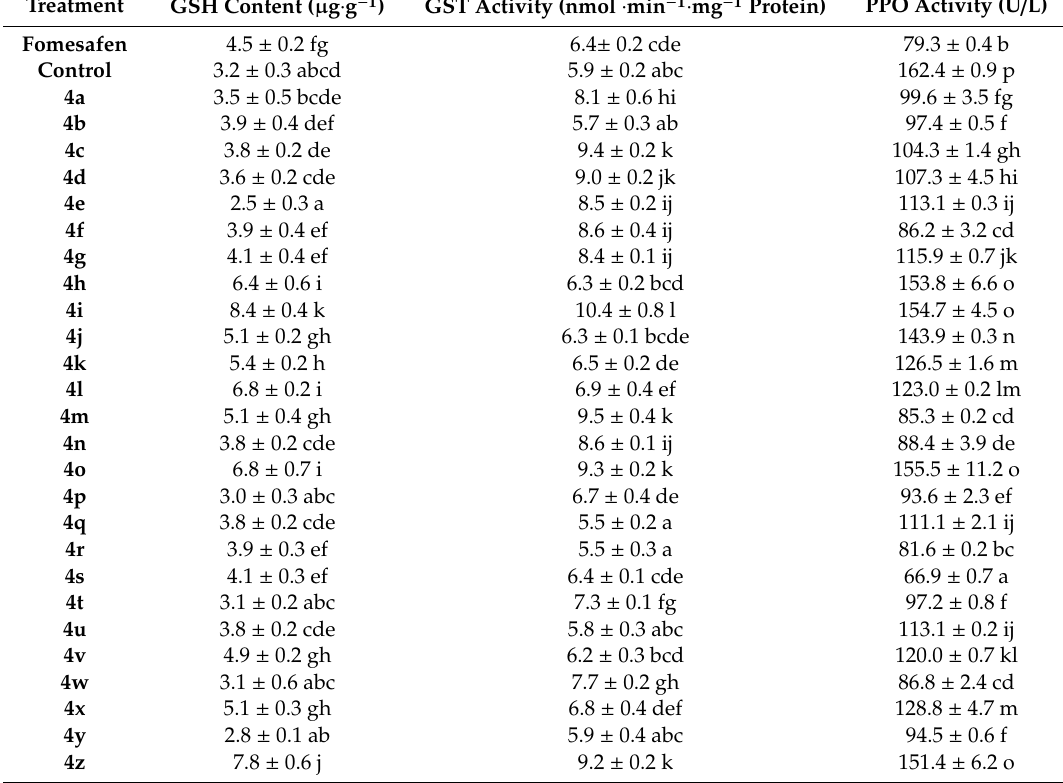
Table 3. E ff ect of compounds on GSH, GST, and PPO activity of maize I,II